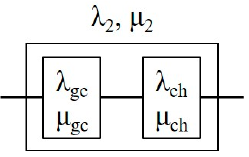
Figure 4. The series structure in Group 2.